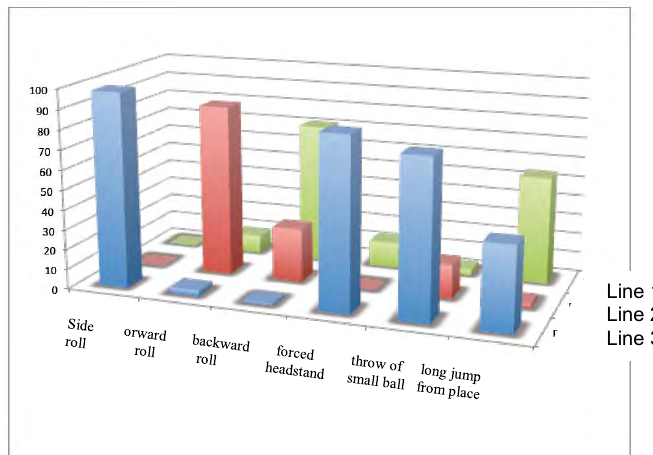
Fig.1. Diagram of relation of mean squares (%). 14 years’ age boys: line1— Х 1 (quantity of repetitions), line 2 — Х 2 (rest interval), line 3 — Х 1 Х 2 (interaction of quantity of repetitions and rest intervals)